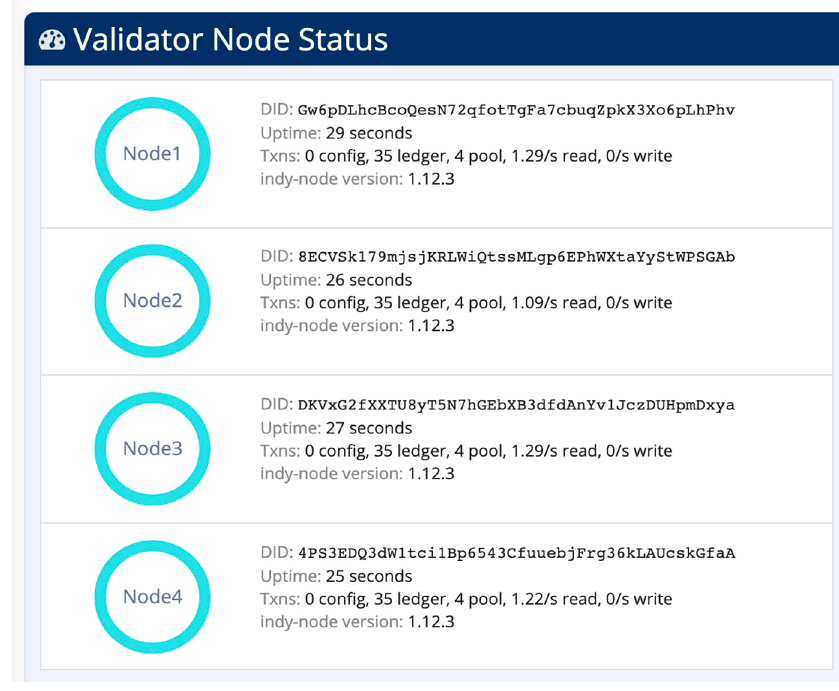
Figure 8. The von-network running in cloud CDM.